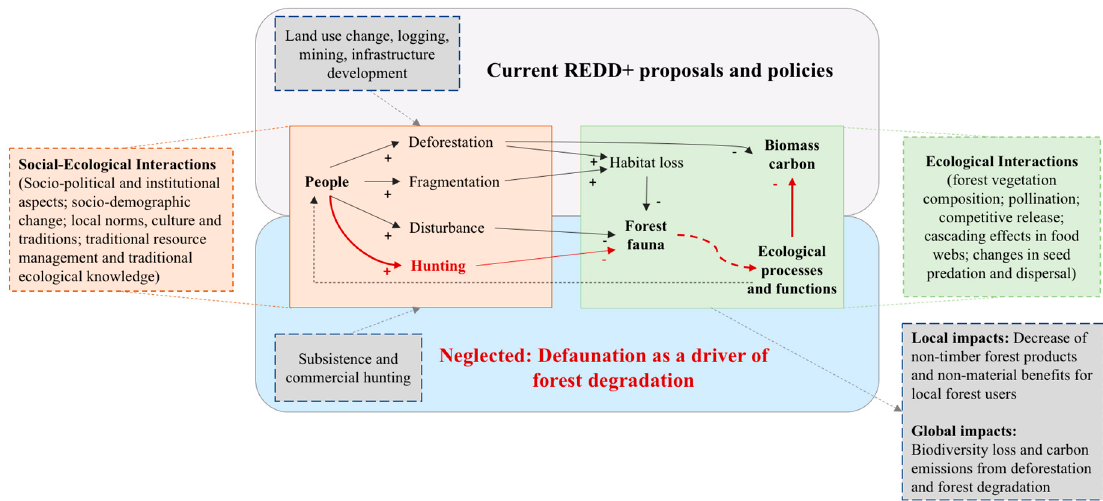
Figure 1. A conceptual framework of defaunation as the missing piece in forest governance.